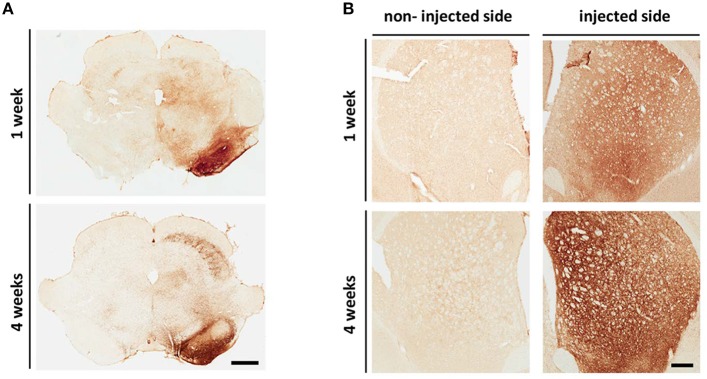
AAV8 SL1SL2 transduction results in human αsyn over-expression along the nigrostriatal pathway. (A,B) Representative brightfield photomicrographs of SN (A) and STR (B) at 1 and 4 weeks. Coronal sections immunostained with an antibody specific for hαsyn (clone 4B12) had expression of the transgenes in the injected SN (A). The expression was also detected at the striatal level (B) with a more intense staining at 4 weeks, scale bar A, 1 mm; B, 500 μm.